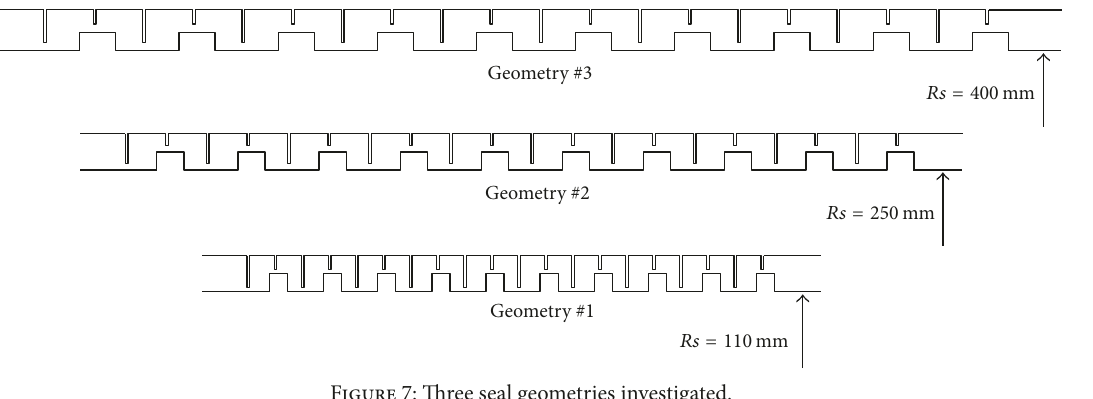
Figure 7: Three seal geometries investigated.